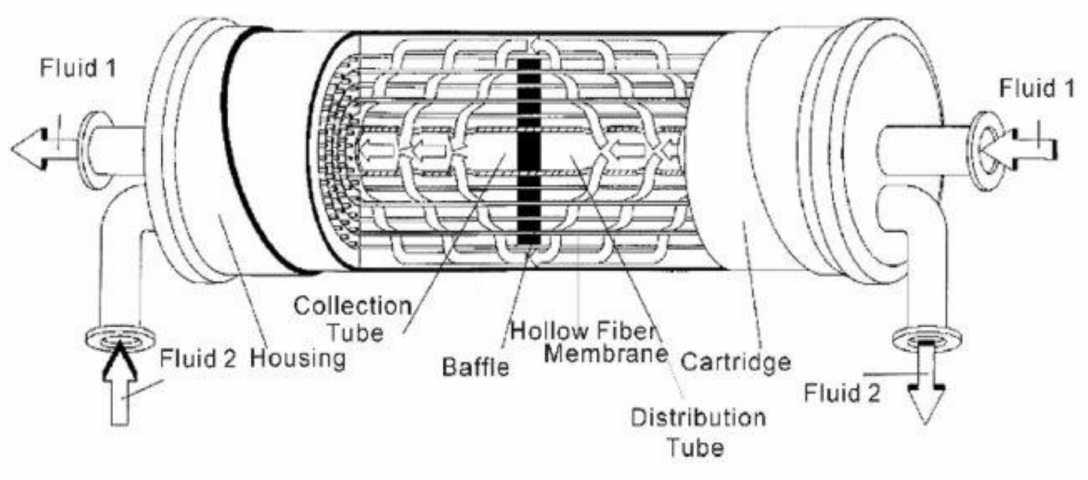
Figure 4. Demonstration of hollow-fiber membrane contactors for olefin / para ffi n separation